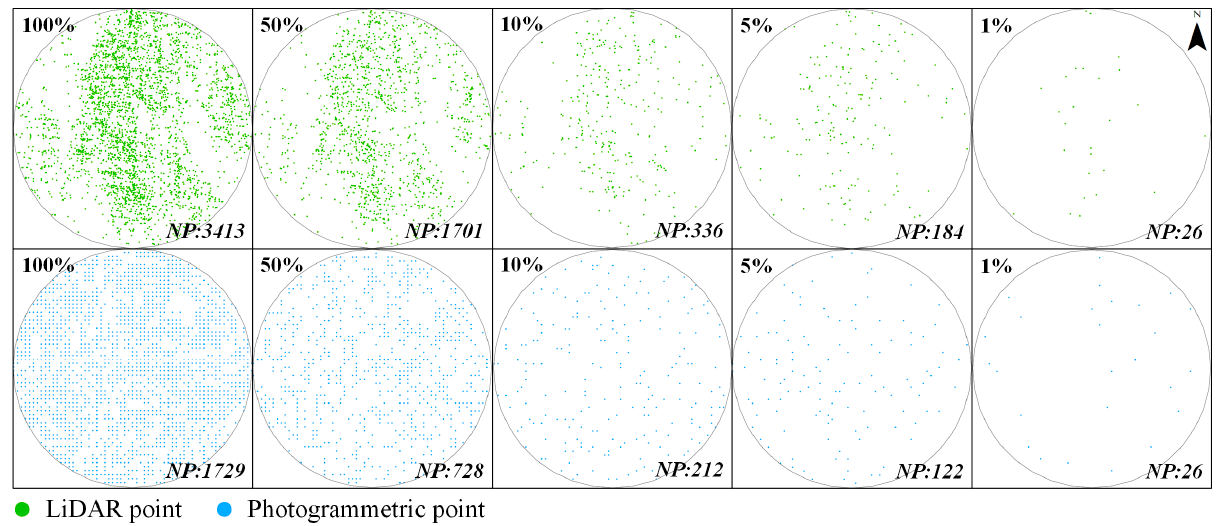
Figure 3. Illustration of percentage-based LiDAR and photogrammetric point cloud decimation. The radius was 5 m, and NP denotes the number of points.